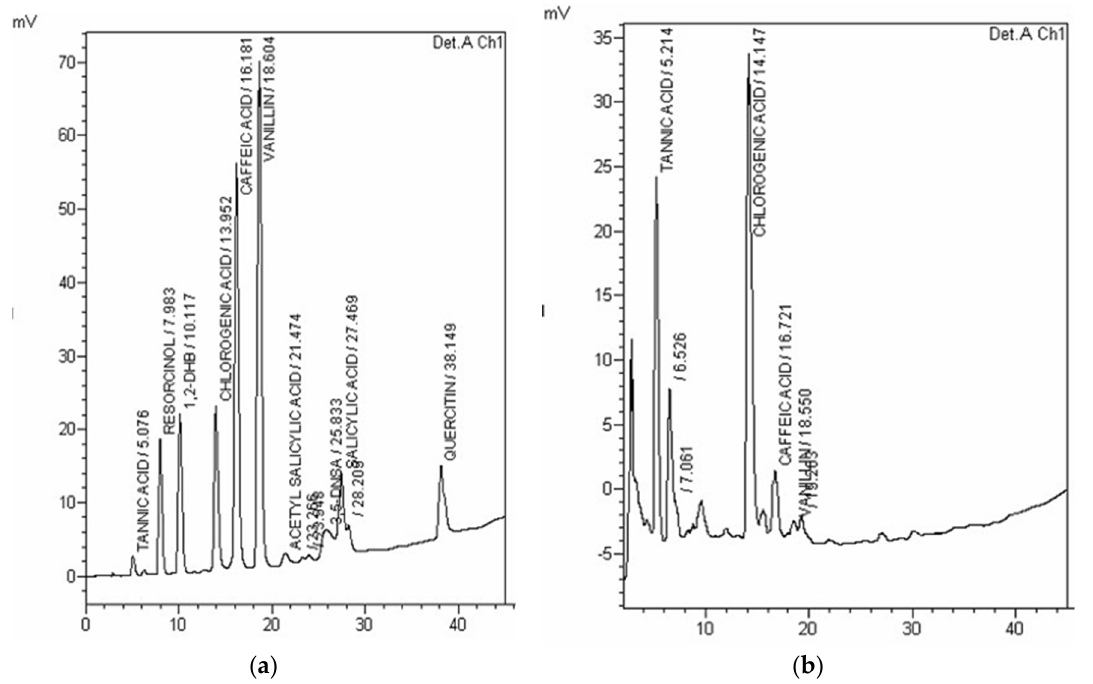
Figure 6. HPLC chromatograms: ( a ) standard compounds; ( b ) high-cooked eggplant extracted with 100%